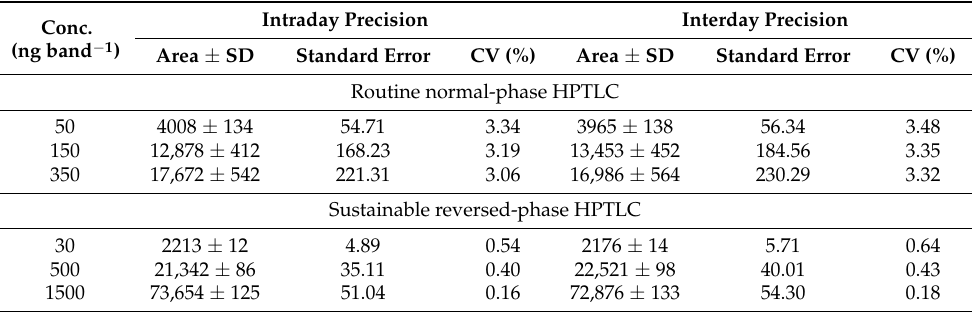
Table 4. Measurement of intra/interday precision of PT for the routine normal-phase HPTLC and the sustainable reversed-phase HPTLC techniques (mean ± SD; n =